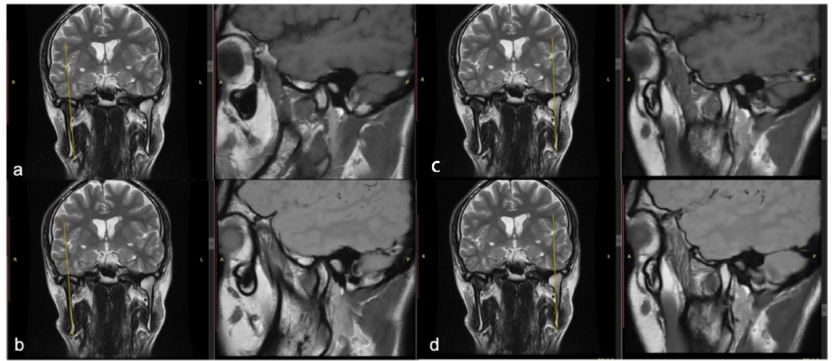
Figure 10. ( a – d ). MRI images: ( a ) right side—closed mouth; ( b ) right side—open mouth; ( c ) left side—closed mouth; ( d ) left side—open mouth (age